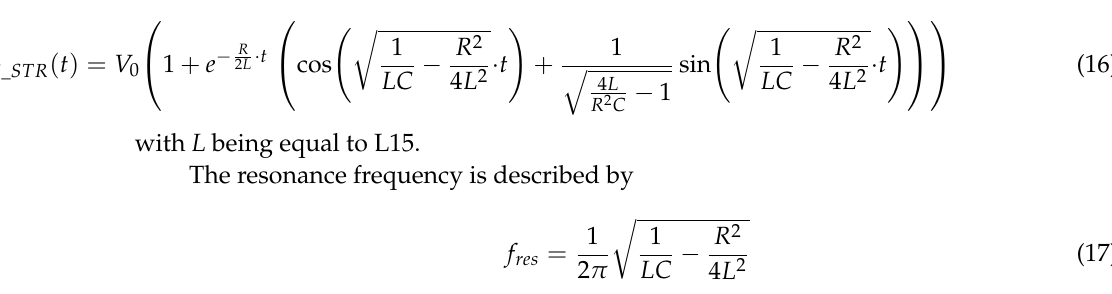
Figure 19. Distribution of the charging current along the charging path according to the position in the generator for an on-time of the solid-state switches of 200 µs. The notation is equal to Figure 18. Figures 20 and 21 show a simulation of the current distribution in the charging path for the common mode in the case of an on-time of the switch of 22 µs. The common mode component of the current is caused by the pulse voltage, which is applied to the current- compensated chokes during pulse generation. Its amplitude is not higher than a few am- peres, which is 3.5 A in this simulation. Initially, as long as the rising charging current is still lower than the common-mode current, a part of the magnetic energy in the core of the leftmost current-compensated choke is partly transferred to the stage capacitor C1 and the damping resistor R D . Hence, as shown in Figure 20, a voltage drop across R D appears as long as the common-mode current component of the choke (L1, L2), I L1L2,C , decays. There- fore, during the charging process, the common-mode current component and, hence, the magnetic energy stored in the core of the leftmost current-compensated choke is signifi-